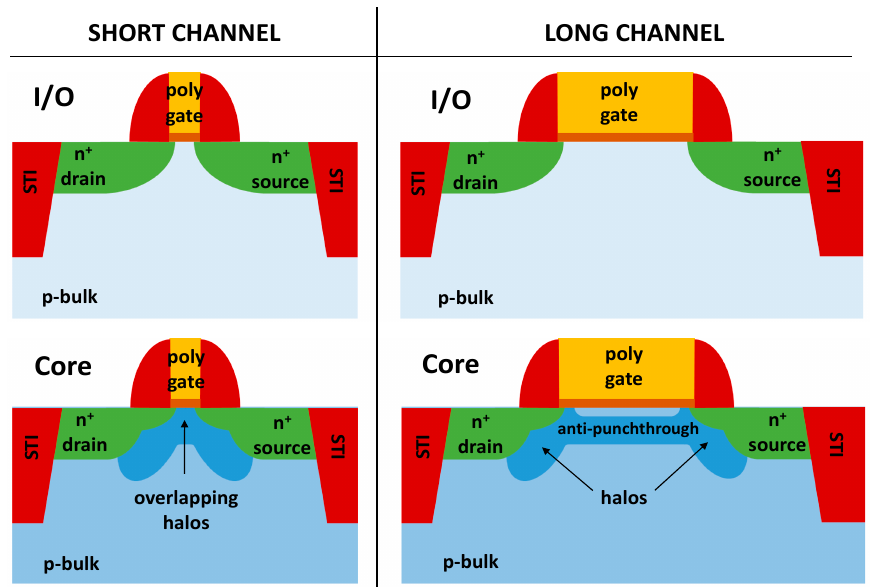
Figure 1. Schematic representation of I/O and core nMOSFETs designed in short and long-channel dimensions. I/O transistors are fabricated with the typical fabrication process of planar CMOS devices. Core transistors are fabricated by using LDD extensions, an anti-punchthrough implantation and source/drain halos. By decreasing the channel length, the drain halo overlaps with the source one, increasing the overall channel doping.